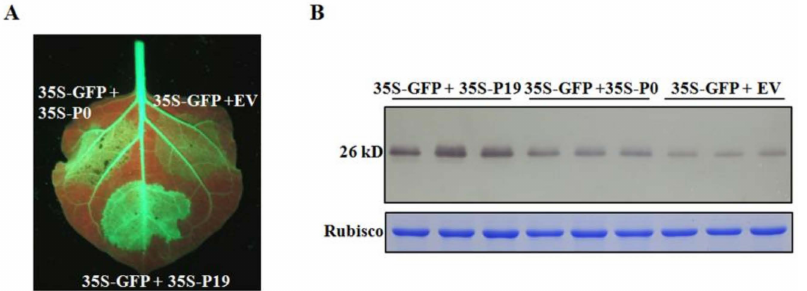
Figure 9. Suppression of GFP local silencing by CVEV-DT1 P0 protein. ( A ) Effect of CVEV-DT1 P0 protein on GFP local silencing in transgenic N. benthamiana line 16C expression GFP. The photographs were taken at 3 dpi under UV light. ( B ) Detection of the accumulation of GFP protein extracted from agroinfiltrated patches shown in ( A